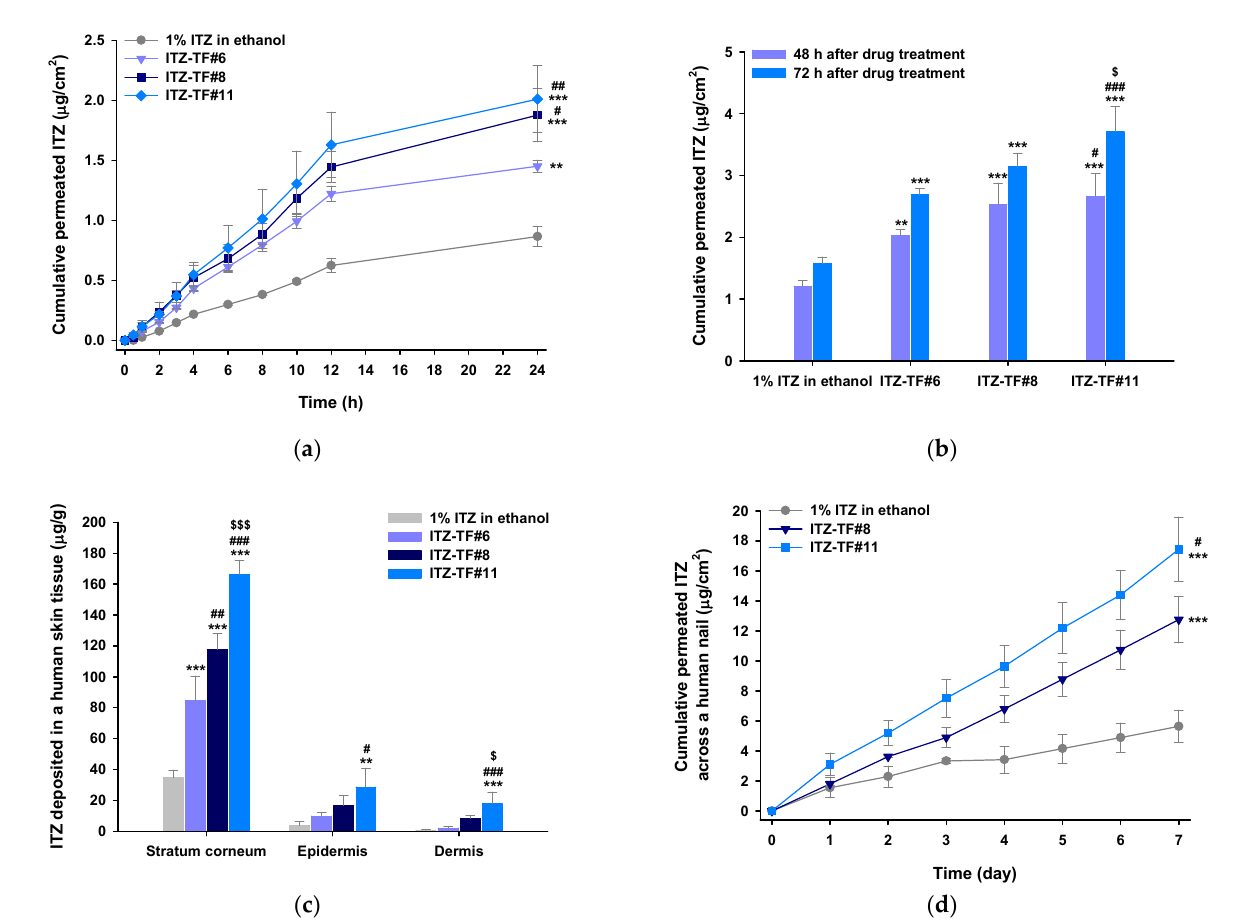
Figure 1. The in vitro full-thickness human skin and nail permeabilities of itraconazole (ITZ) from 1% ITZ in ethanol, ITZ–TF#6, ITZ–TF#8, and ITZ–TF#11. ( a ) The cumulative ITZ levels that permeated human skin over 24 h. ( b ) Cumulative human skin ITZ infiltrations at 48 and 72 h. ( c ) ITZ concentrations/g of stratum corneum, epidermal, and dermal tissues. ( d ) The time course of cumulative, partitioned drug concentrations across human nails from day 1 to 7. Each value is a mean ± standard deviation ( n = 4). ** p < 0.01, *** p < 0.001 compared to 1% ITZ in ethanol. # p < 0.05, ## p < 0.01, ### p < 0.001 compared to ITZ–TF#6. $ p < 0.05, $$$ p < 0.001 compared to ITZ–TF#8.